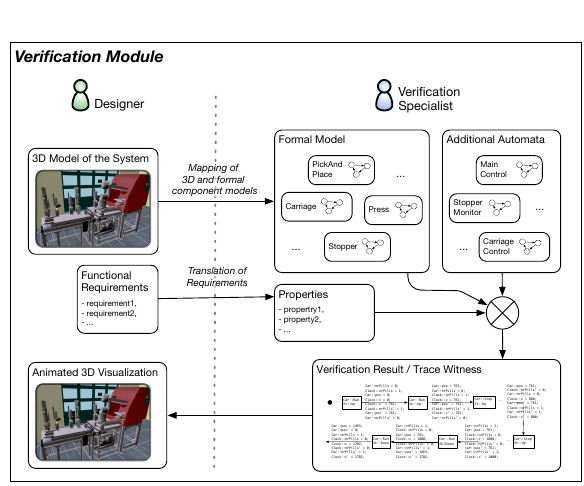
Figure 5. Collaborative